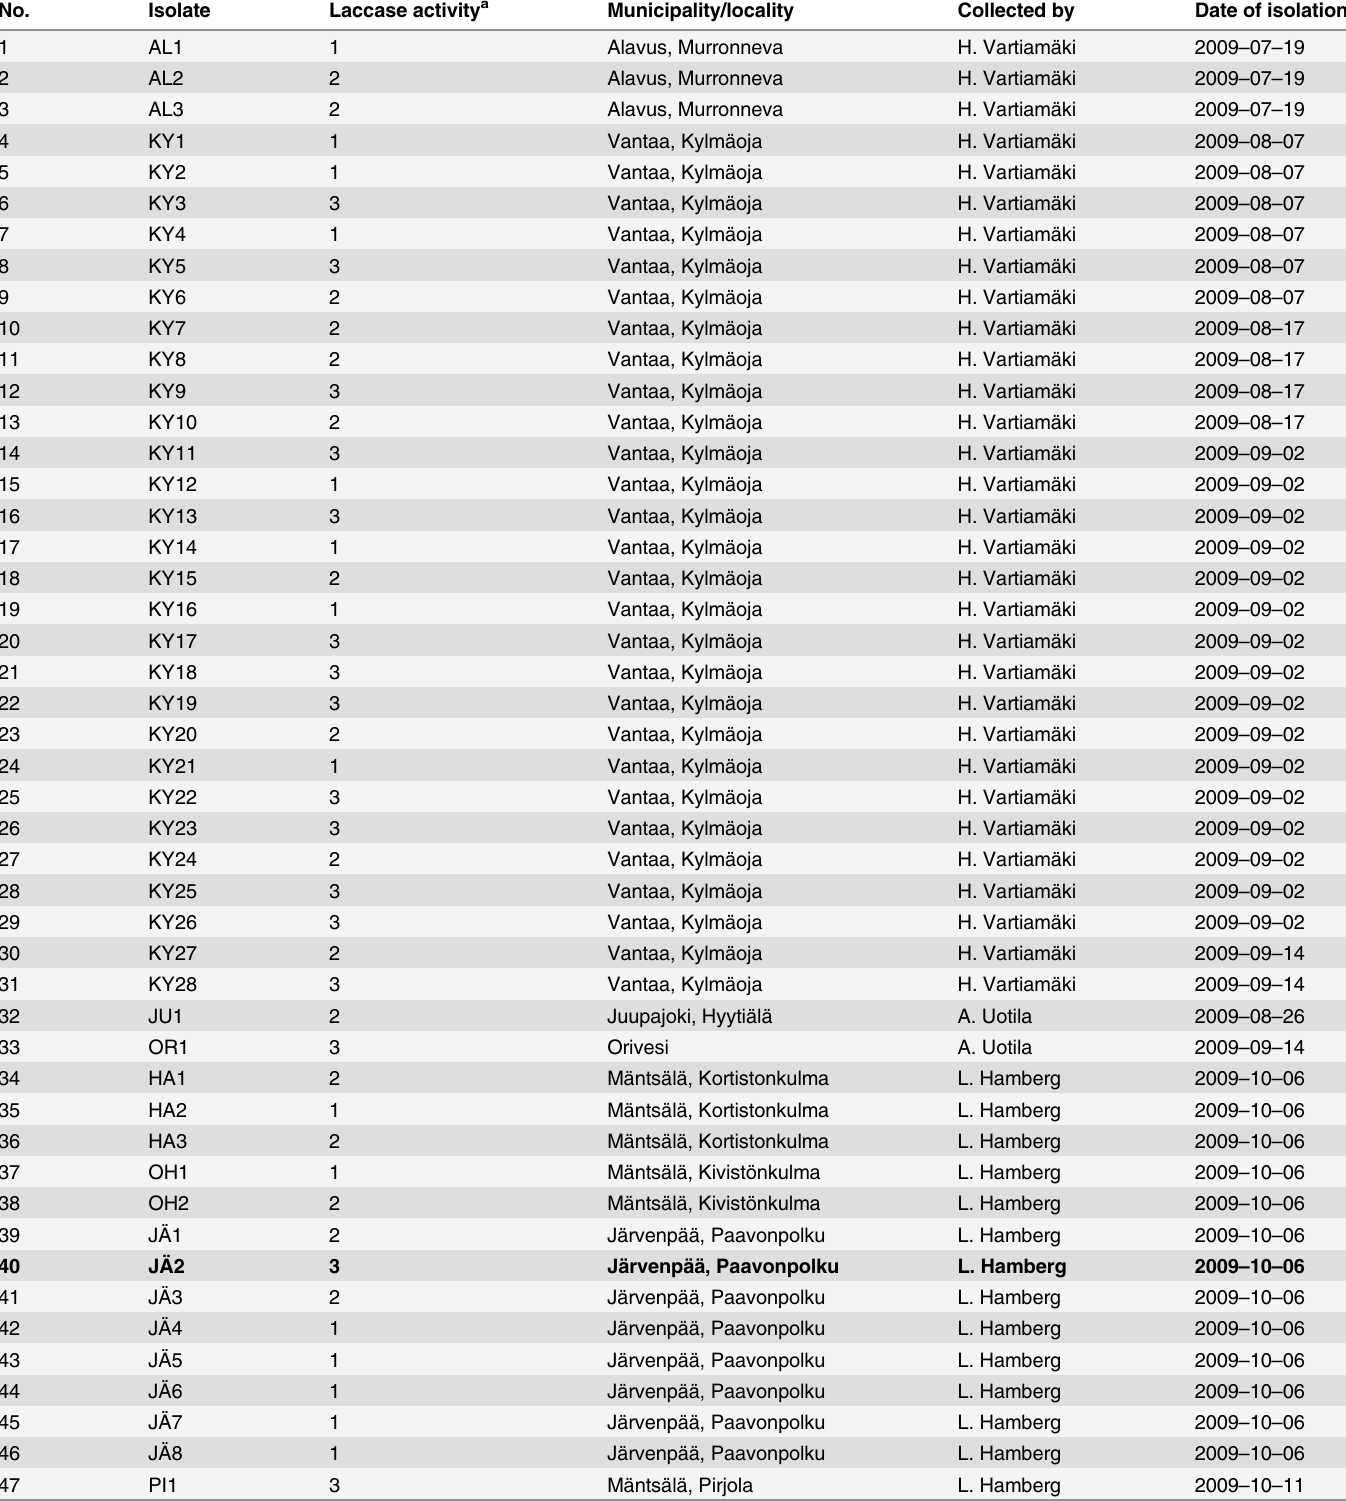
Table 1. Chondrostereum purpureum Isolates Collected for Phase 1.